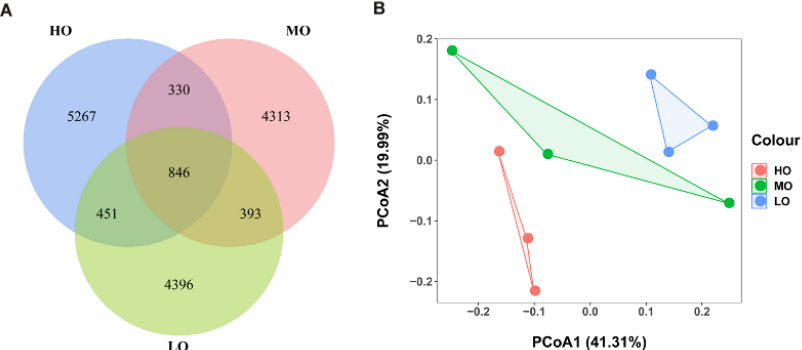
Figure 1. Microbial community among different treatments ( n = 3). ( A ) Venn diagram representing the common and unique operational taxonomic units (OTUs) found at each treatment. ( B ) Principal coordinates analysis (PCoA) of samples conducted based on weighted UniFrac distance. LO, low oat percentages group; MO, medium oat percentages group; HO, high oat percentages group.